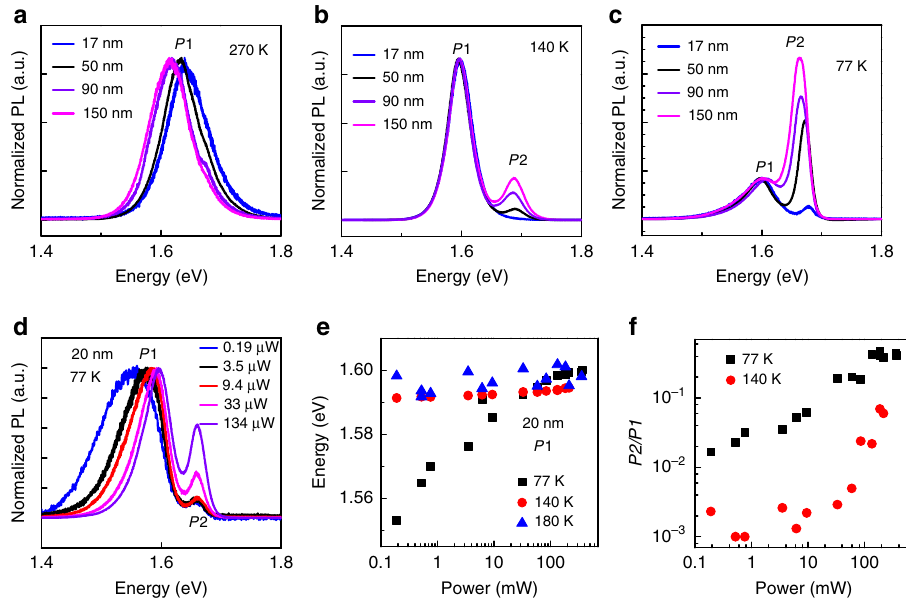
Figure 4 | Thickness and excitation power-dependent photoluminescence studies. ( a – c ) The photoluminescence spectra for four different thickness halide perovskite microplates at 270K ( a ), 140K ( b ) and 77K ( c ). A 488-nm laser with a power of 3.5 m W was used as the excitation source. All spectra are normalized by the low-energy peak P 1 in order to easily compare among each other. ( d ) The excitation power-dependent PL spectra for a 20-nm-thick microplate at 77K. The spectra have been normalized by the low-energy emission peak P 1. ( e ) The excitation power-dependent emission peak position of the tetragonal phase for the 20-nm perovskite microplate. ( f ) The P 2/ P 1 ratios extracted from their corresponding PL spectra under different excitation power at 77K (black squares) and 140K (red